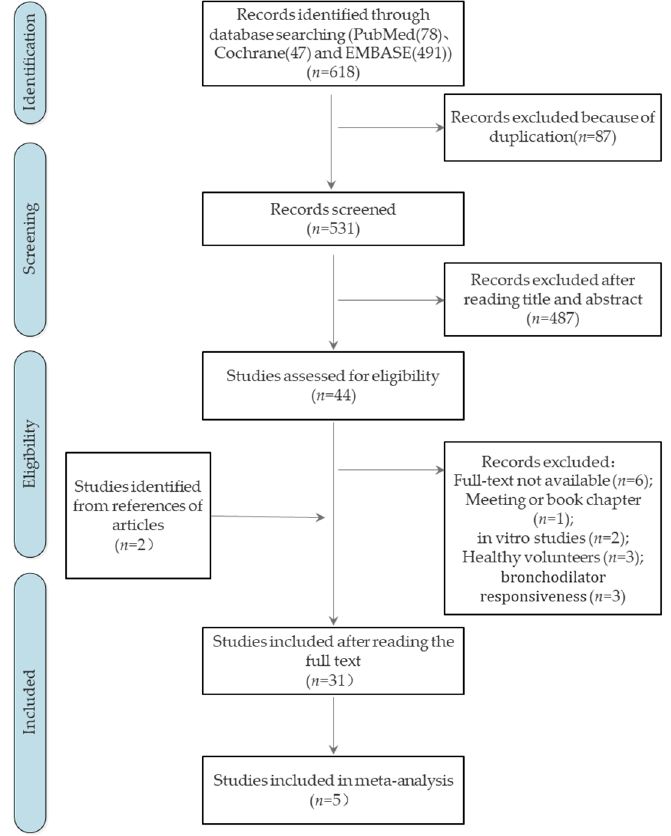
Figure 1. Screening process. Table 1. Included pharmacogenomics studies of response to LTMs in systematic review.